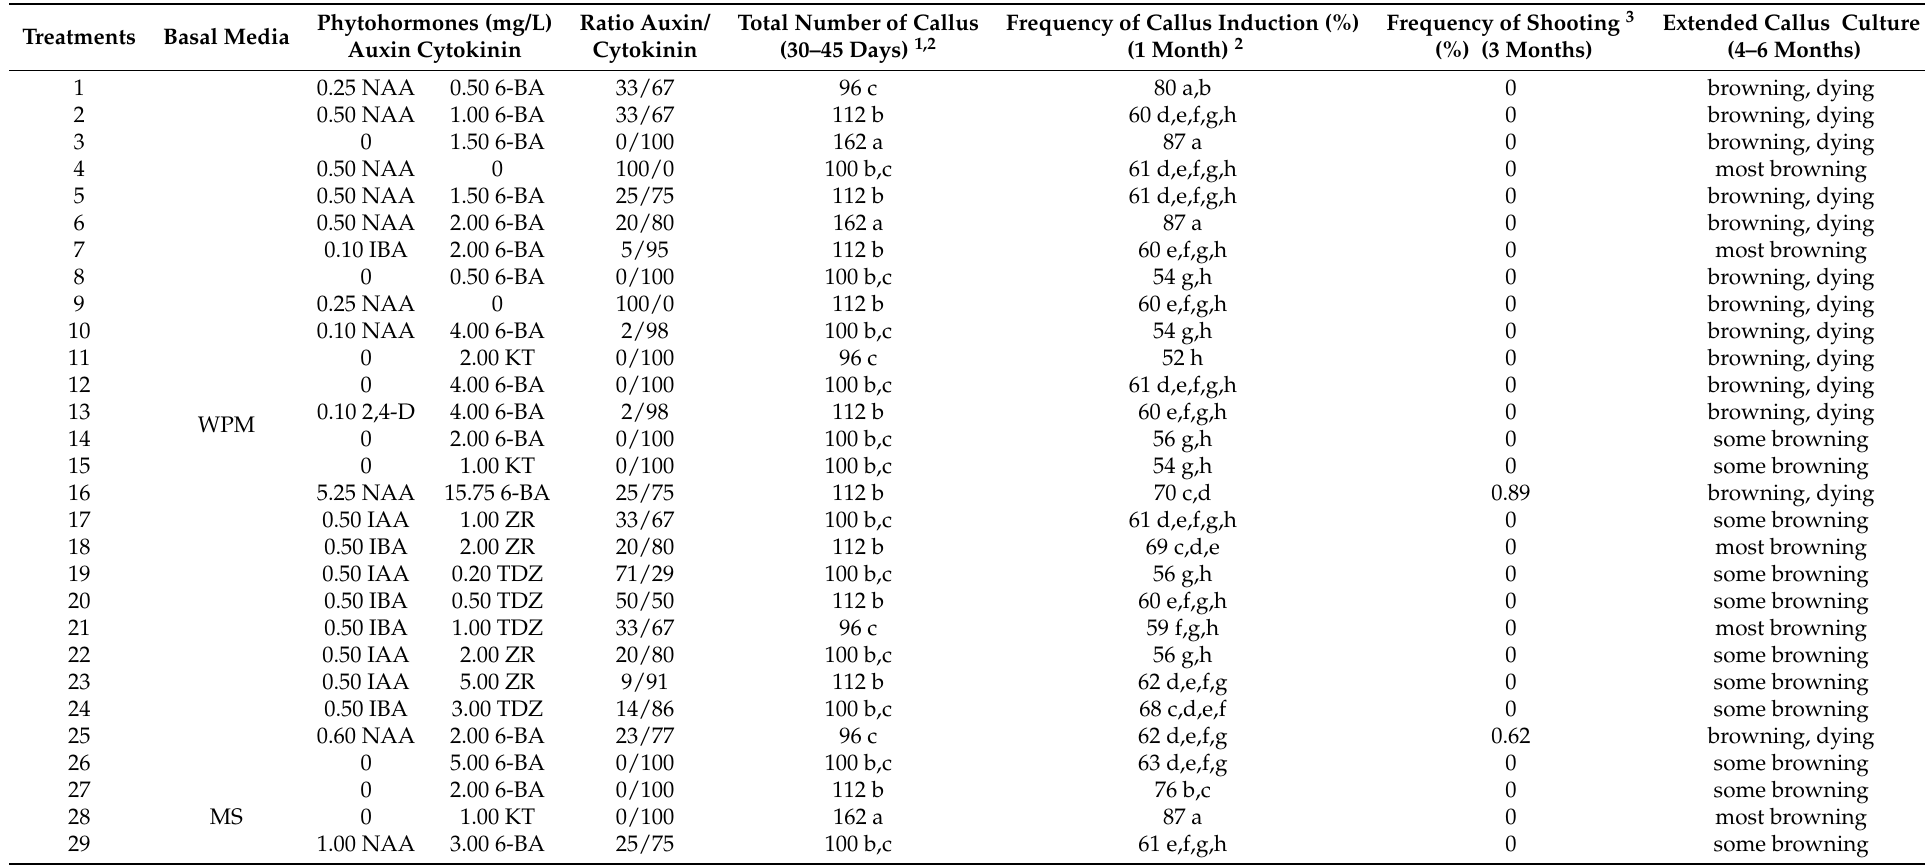
Table 2. Effect of plant growth regulators on callus induction from stem segment and shooting rate of J. mesnyi